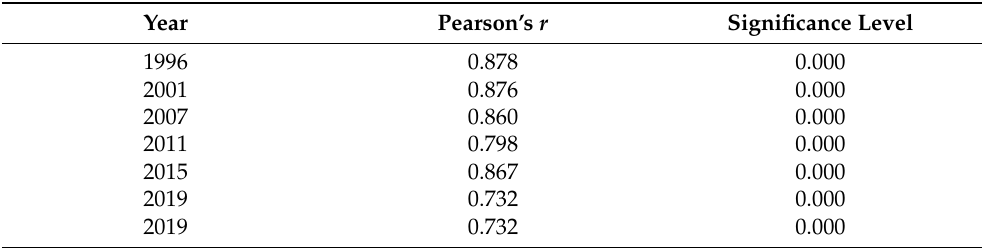
Table 4. Correlation between the percentage of built-up land (PLAND) and land surface temperature (LST) from 1996 to 2019.